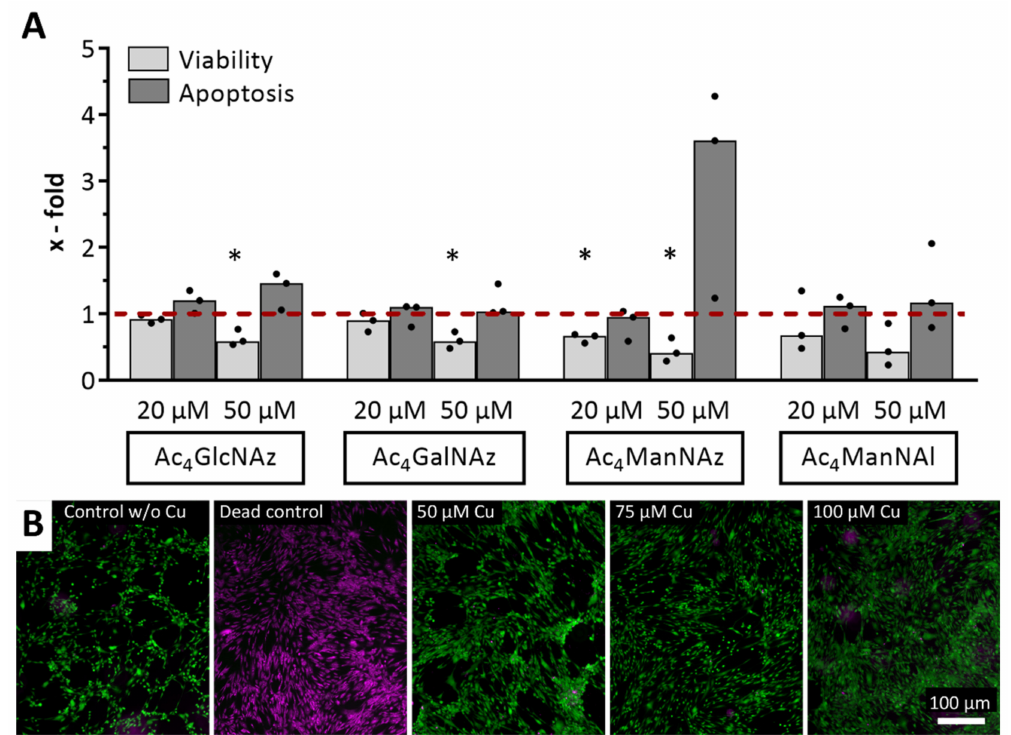
Figure 1. Cell viability of telomerase-immortalized human mesenchymal stromal cells (hMSC-TERT) after treatment with click reagents. ( A ) Viability and apoptosis rates after 72 h incubation with different modified monosaccharides relative to DMSO-treated control (dashed line). Datasets (median with individual values) were tested for significance using two-tailed paired t -test ( p < 0.05 depicted as *). ( B ) Live/dead staining after 5 min incubation with Cu(I)-containing click reaction mixture. Green: fluorescence signal of living cells, magenta: fluorescence signal of dead cells. Representative images of three independent experiments are